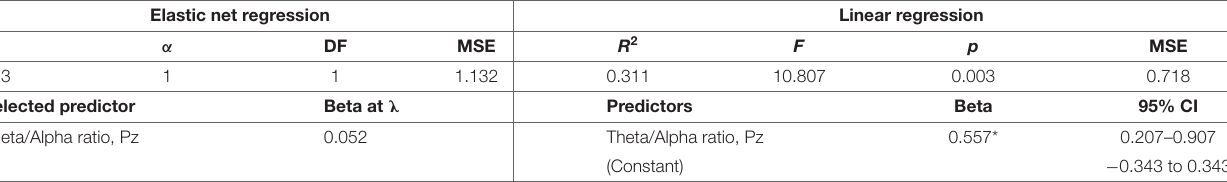
TABLE 6 | Regressions on NSI cognitive. Elastic net regression